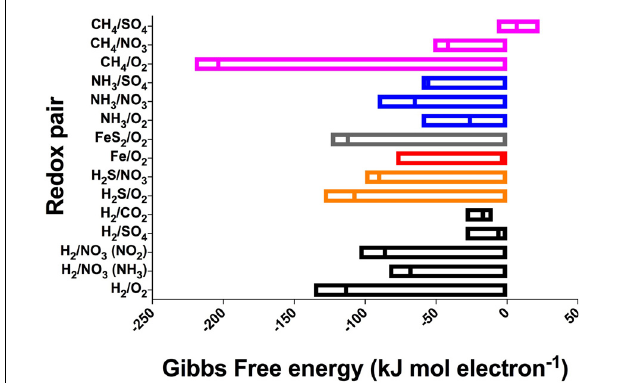
FIGURE 3 | Range and mean of Gibbs Free energy yields, normalized to kJ per mole electron transferred per reaction, across all sites for the redox pairs listed in Table 1 . Negative values indicate exergonic reactions. See Supplementary Table S1 for all values. Reactions grouped by electron donor and color (pink, CH 4 ; blue, NH 3 ; gray, FeS 2 ; red, Fe 2 + ; orange, H 2 S; black, H 2